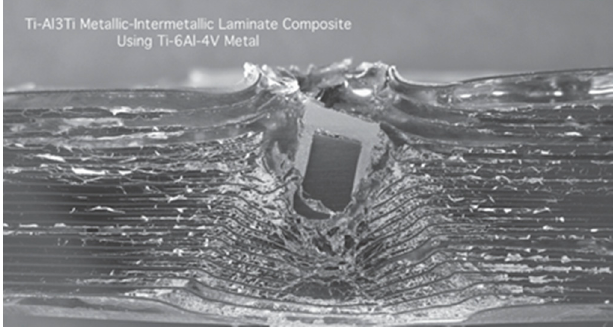
Figure 2. A cross section of the impact location from a ballistic test on an MIL composite.